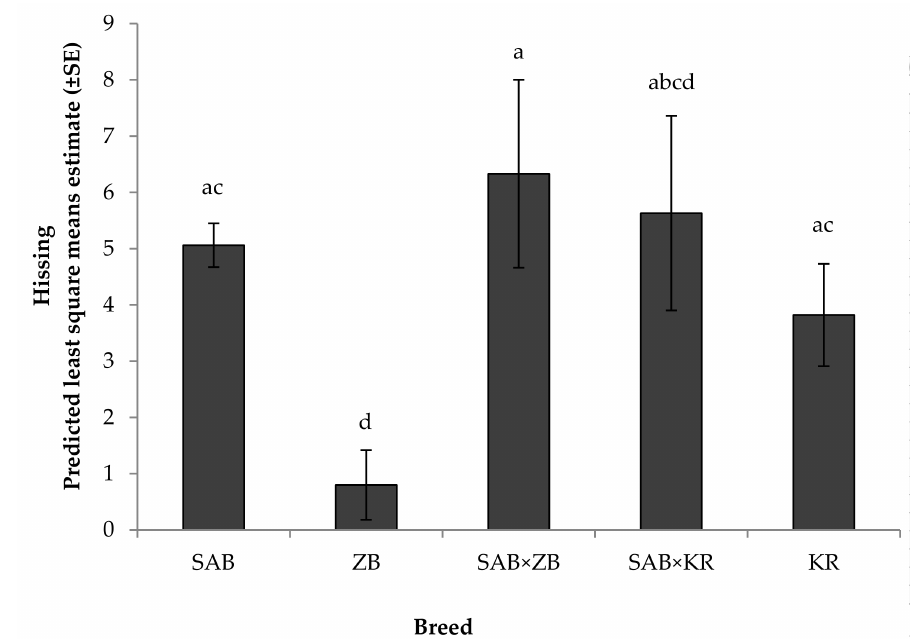
Figure 7. Means depicting the effect of breed on hissing by ostriches in the reactivity tests that approached the handler ( N = 207). SAB: South African Black ( N = 160); ZB: Zimbabwean Blue ( N = 5); KR: Kenyan Redneck ( N = 4); and their cross-bred combinations: SAB × ZB ( N = 19) and SAB × KR ( N = 19). Means with different superscripts differed significantly ( p <